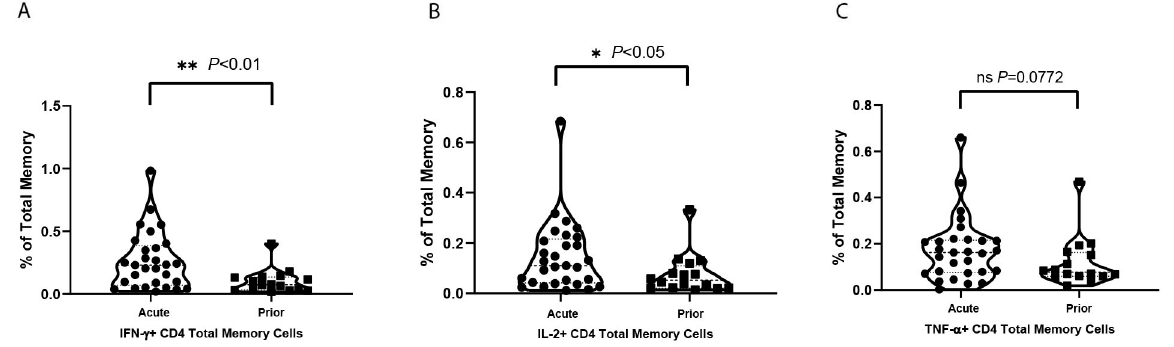
Figure 1 . Violin plots for cytokine positive T-cell percentages under VZV stimulation in total memory CD4+ T cells. Net positive (VZV stim – no stim control) displayed as % positive with each dot as a unique individual: (A) IFN-γ positive total memory CD4+ T-cell percentages of total memory T cells; (B) IL-2 positive total memory CD4+ T-cell percentages of total memory T cells; (C) TNF-α positive total memory CD4+ T-cell percentages of total memory T